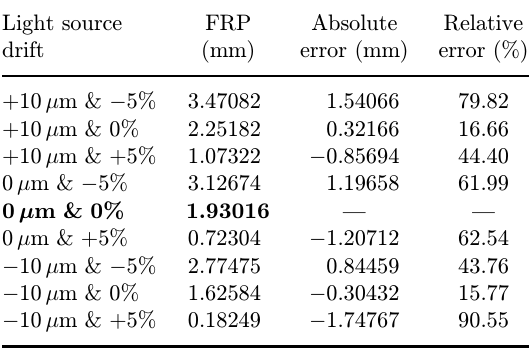
Fig. 8. The °oating reference curves with positioning errors and light source drift errors: (a) without NP model and (b) with NP model. Table 10. Comprehensive errors of positioning inac- curacy and light source drift without NP.